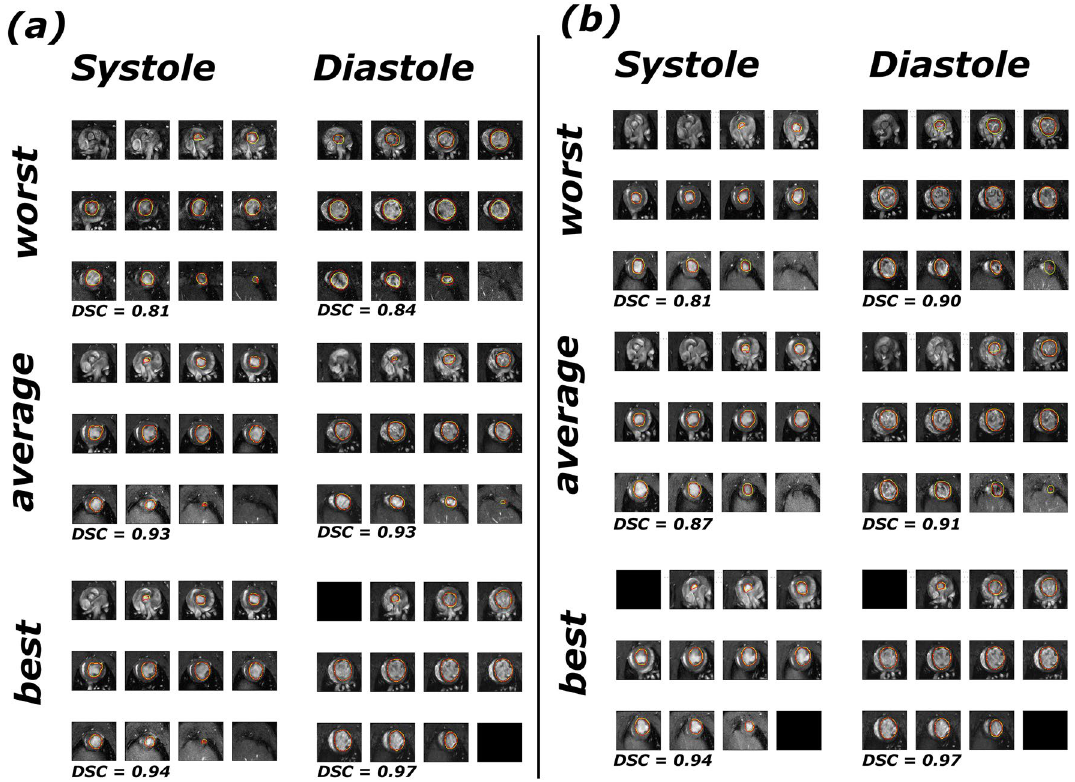
Figure 3. Best, worst and average examples of 1MSA segmented rat hearts with U-Net (systole and diastole) ( a ). Best, worst and average exmaples of 2MSA segmented rat hearts with V-Net (systole), Attention U-Net (diastole) ( b ). In red the predicted mask and in yellow the ground truth (manual